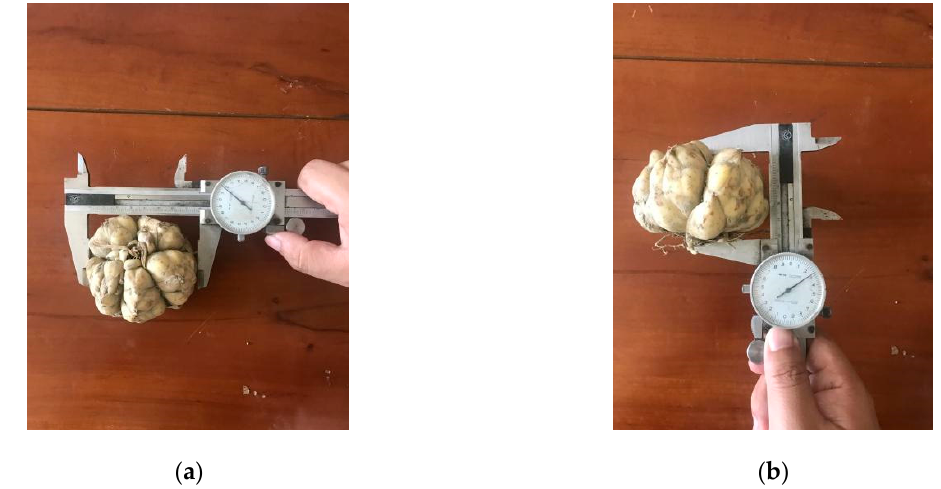
Figure 1. Lily three-axis size measurement. ( a ) Length direction measurement; ( b ) Thickness measurement. Table 1. Three-axis dimensions of lily bulb.